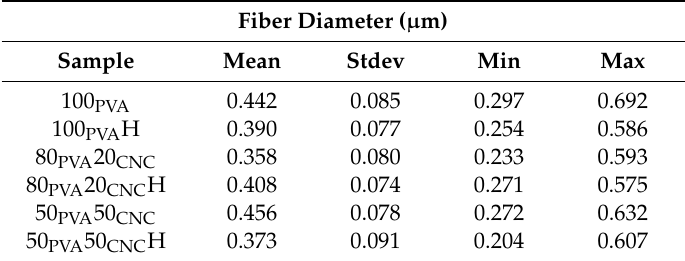
Table 2. Average fiber diameter (nm) with standard deviation, minimum and maximum values by electrospun mat composition. The electrospun mats with heat treatment are labeled